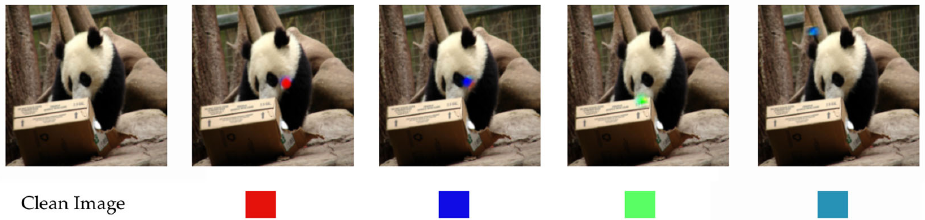
Figure 3. Backdoor pa tt ern visible in adversarial example generated by denoised smoothing triggers.